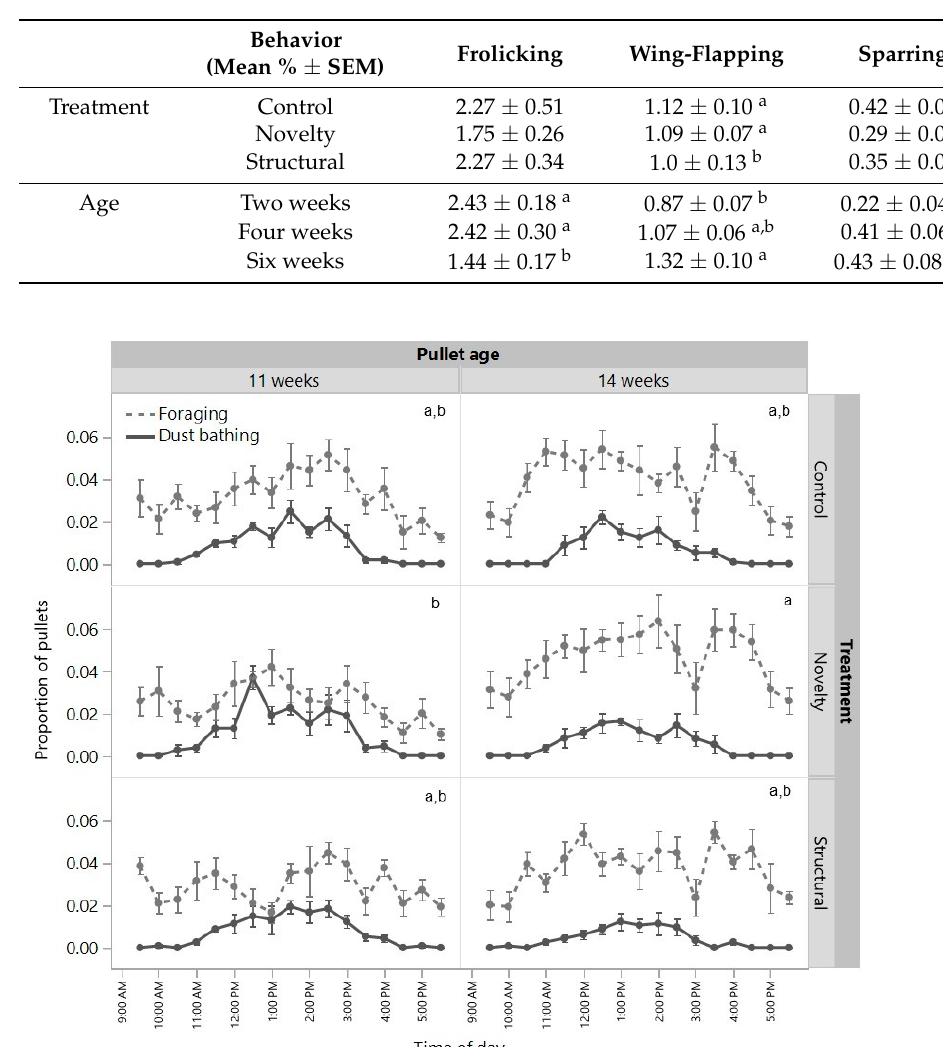
Figure 3. The proportion of pullets from three rearing treatments (control, novelty, structural) dust bathing or foraging across the day as assessed at 11 and 14 weeks of age. a,b Dissimilar letters indicate significant differences between treatments across age for foraging behavior. The raw mean (±SEM) values are presented across the day with statistical tests conducted on transformed daily total means.